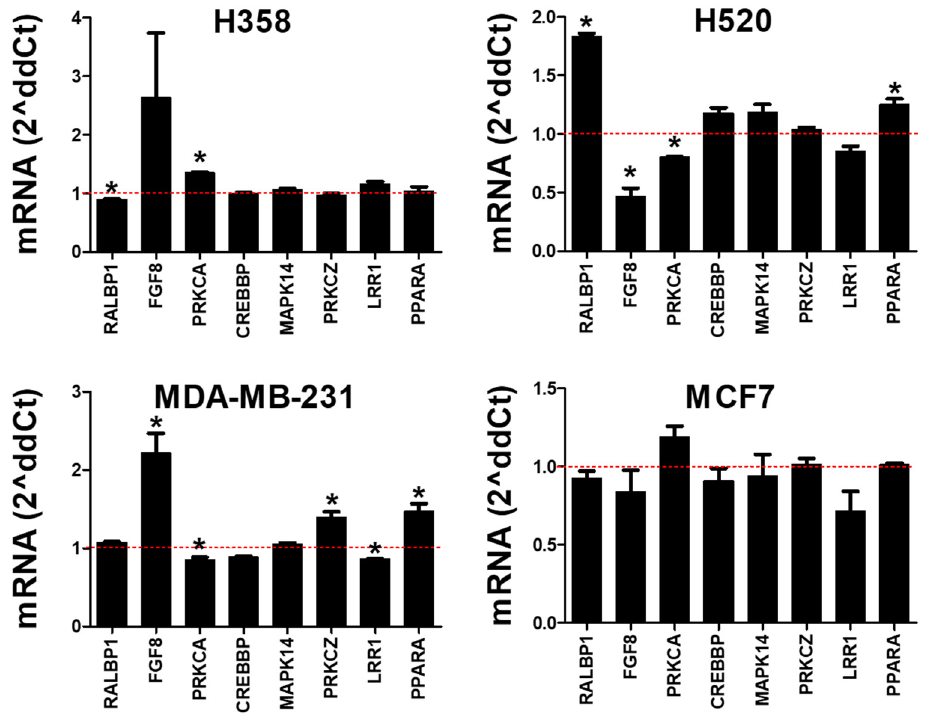
Figure 6. Addition of arachidonic acid minimally alters transcription. Cells were collected 24 h following addition of 150 µ M arachidonic acid, a precursor of the Rlip substrate 4HNE. The results are shown as the fold-change of expression relative to DMSO-treated controls, which were defined as 1 as indicated by the red dotted lines. Asterisks (*) indicate p < 0.05 by Student’s t -test when comparing mRNA expression from each arachidonic acid treatment to its corresponding DMSO control treatment. Error bars indicate SEM ( n = 3).